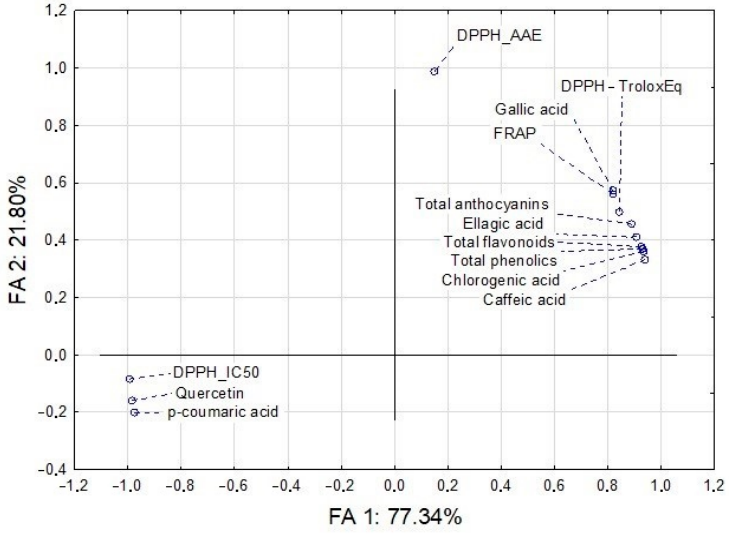
Figure 1. Factor analysis of the chemical profile and antioxidant potential of the raspberry pomace extracts.